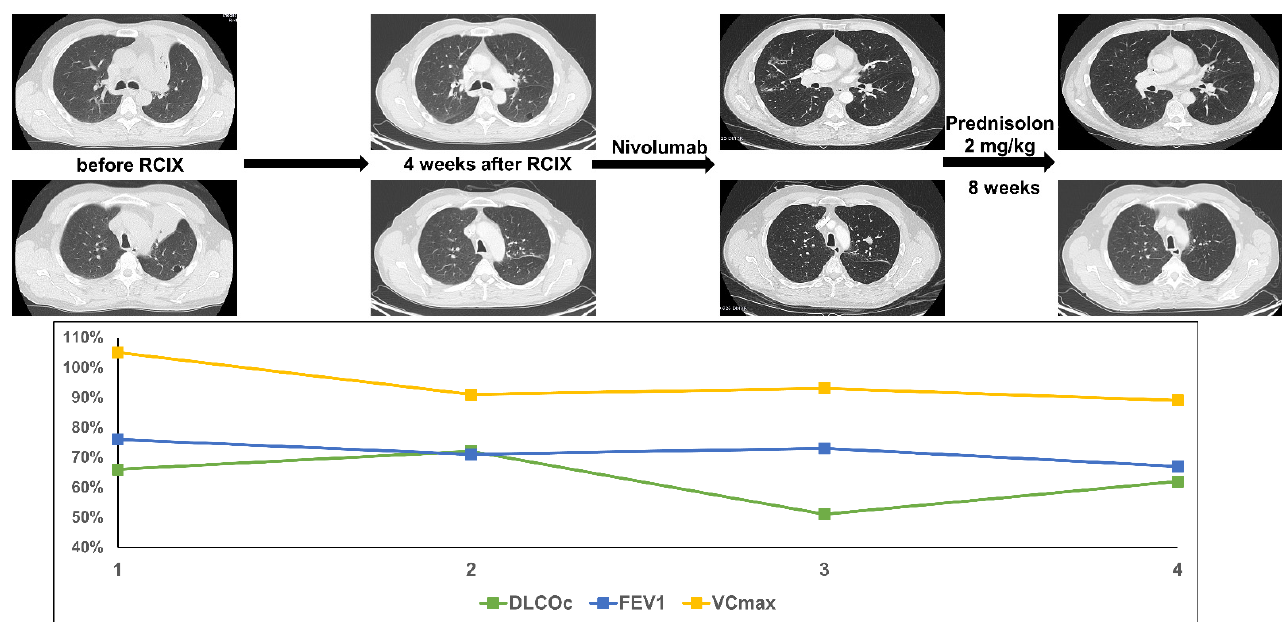
Figure 6. The figure shows course of treatment, corresponding CT imaging and lung function values of patient 6. (RCIX: Radiochemoimmunotherapy).